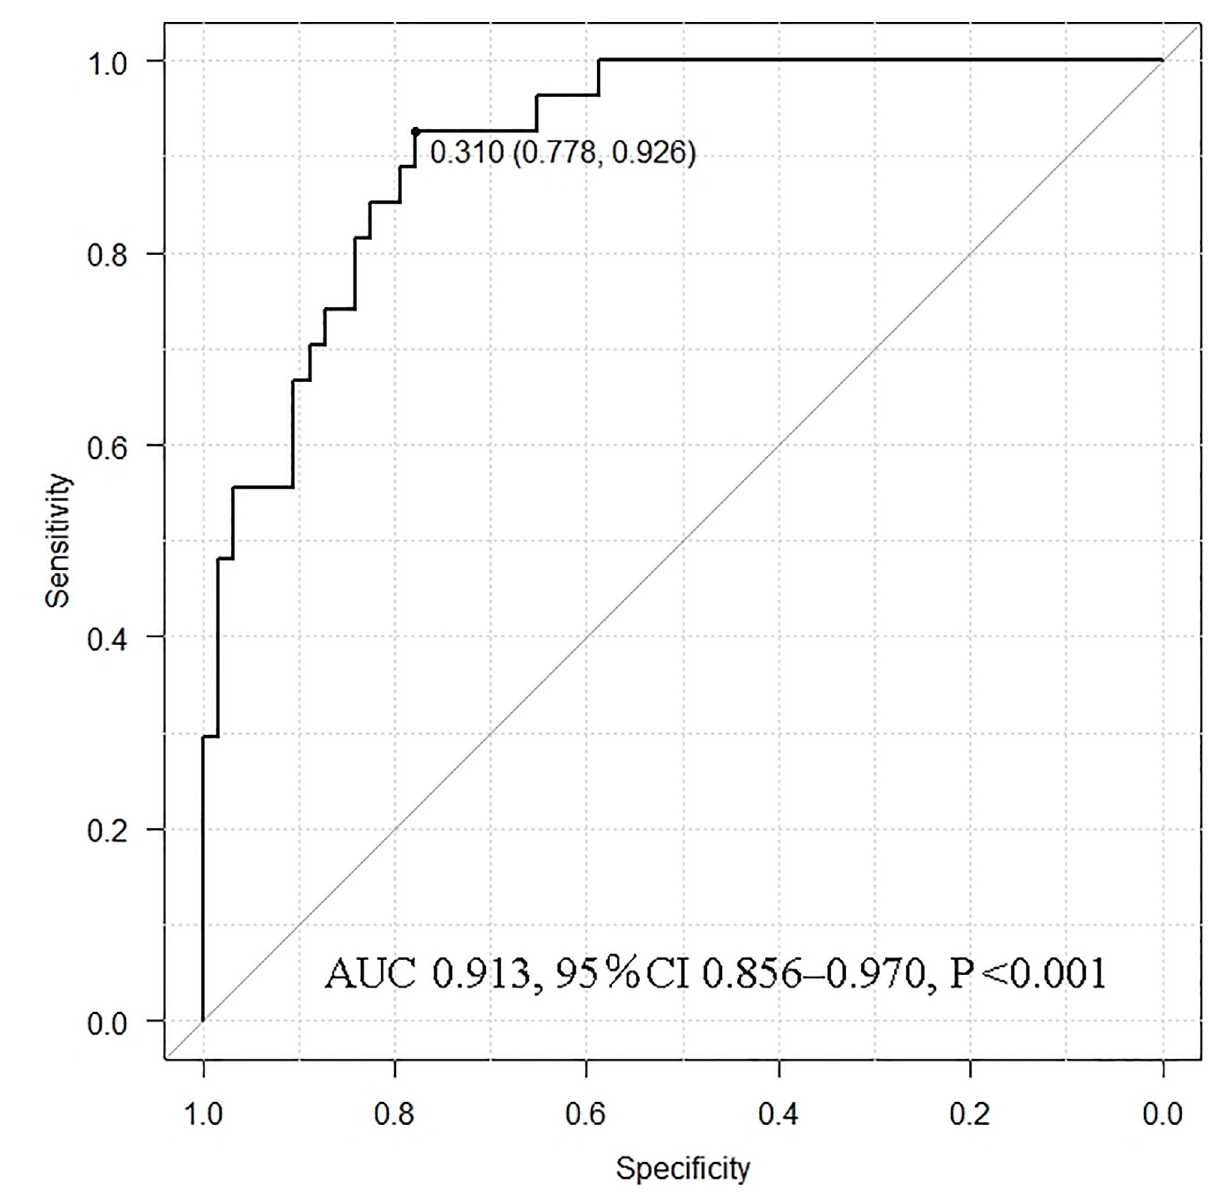
Fig 5. Receiver operating characteristic curve analysis for the cutoff value of recurrence or persistence in the autografted forearm. AUC, area under the curve; CI, confidence interval.